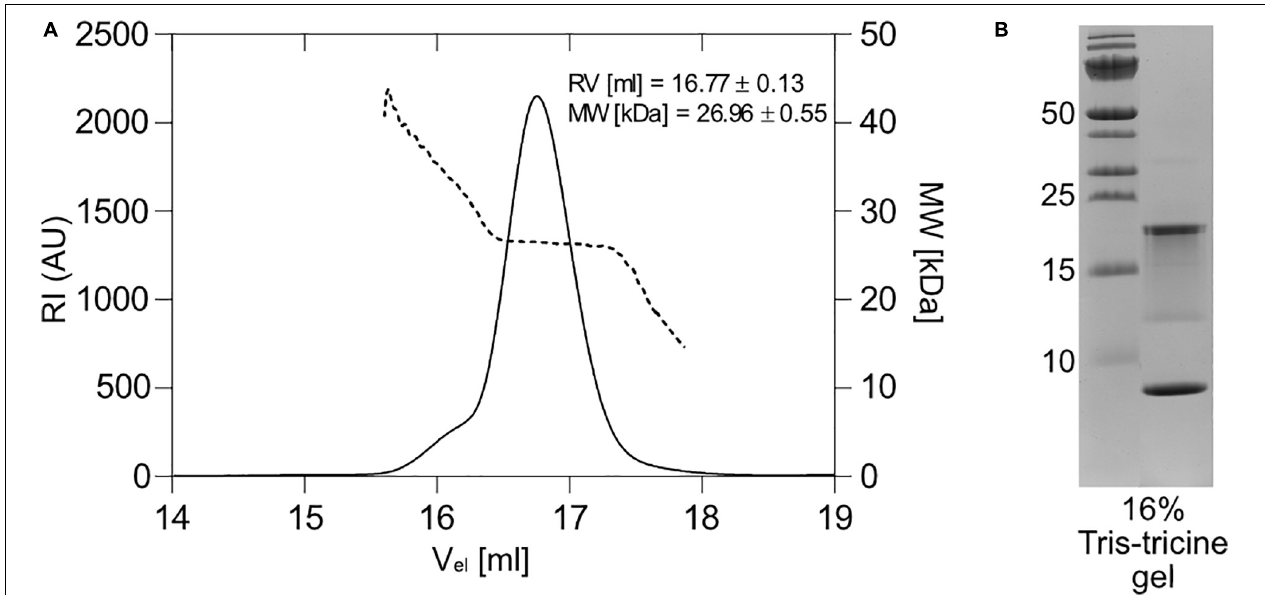
FIGURE 5 | Expression and multimeric form of the 1065–1067 toxin-antitoxin pair. (A) Right and Low Light Scattering (RALS/LALS) showed that in solution, the antitoxin-toxin complex was mostly present as a molecule with an approximate size of 27 kDa, indicating the formation of a heterotrimer, in which two molecules of the antitoxin bind to one molecule of the toxin. (B) 16% Tris-tricine polyacrylamide gel stained with the Coommasie Brilliant Blue dye. The toxin-antitoxin pair was expressed from the native locus arrangement, but with a His-tag at the C-terminus of the toxin and isolated by nickel affinity chromatography. The expected mass is 12.5 kDa for the His-tag labeled toxin and 8.4 kDa for the